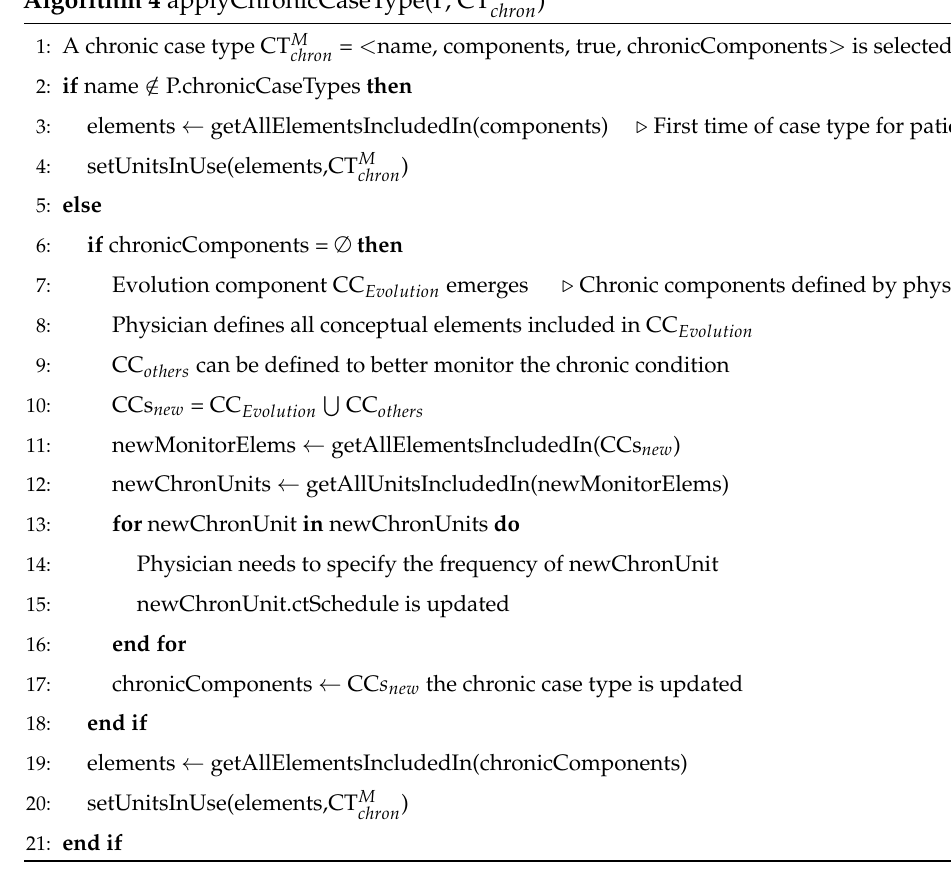
Algorithm 4 applyChronicCaseType(P, CT M